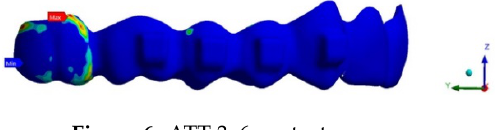
Figure 6. ATT 3–6 contact pressure. Appl. Sci. 2020 , 10 , x FOR PEER REVIEW